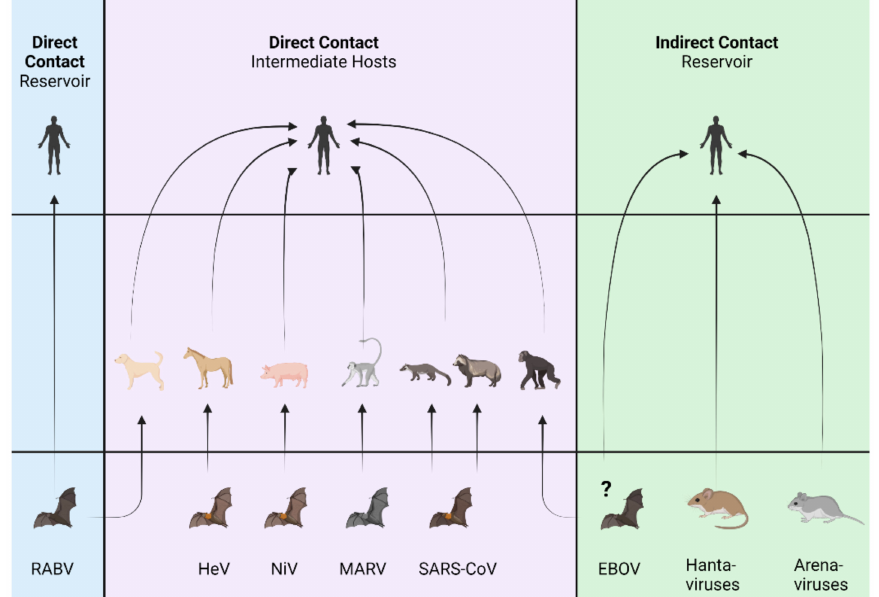
Figure 1. Major routes of spillover transmission of viruses harbored by bats and rodents. Three of the most common routes of exposure from bats or rodents to humans are depicted. As illustrated, more than one route may occur. Abbreviations: RABV, rabies viruses; HeV, Hendra henipavirus ; NiV, Nipah hendravirus ; MARV, Marburg marburgvirus ; SARS-CoV, severe acute respiratory syndrome coronavirus; EBOV, Ebolavirus